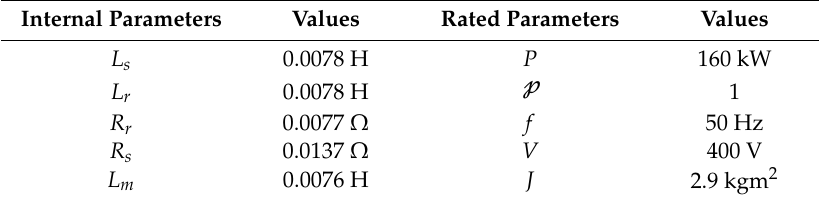
Table A2. Induction motor (IM) data.